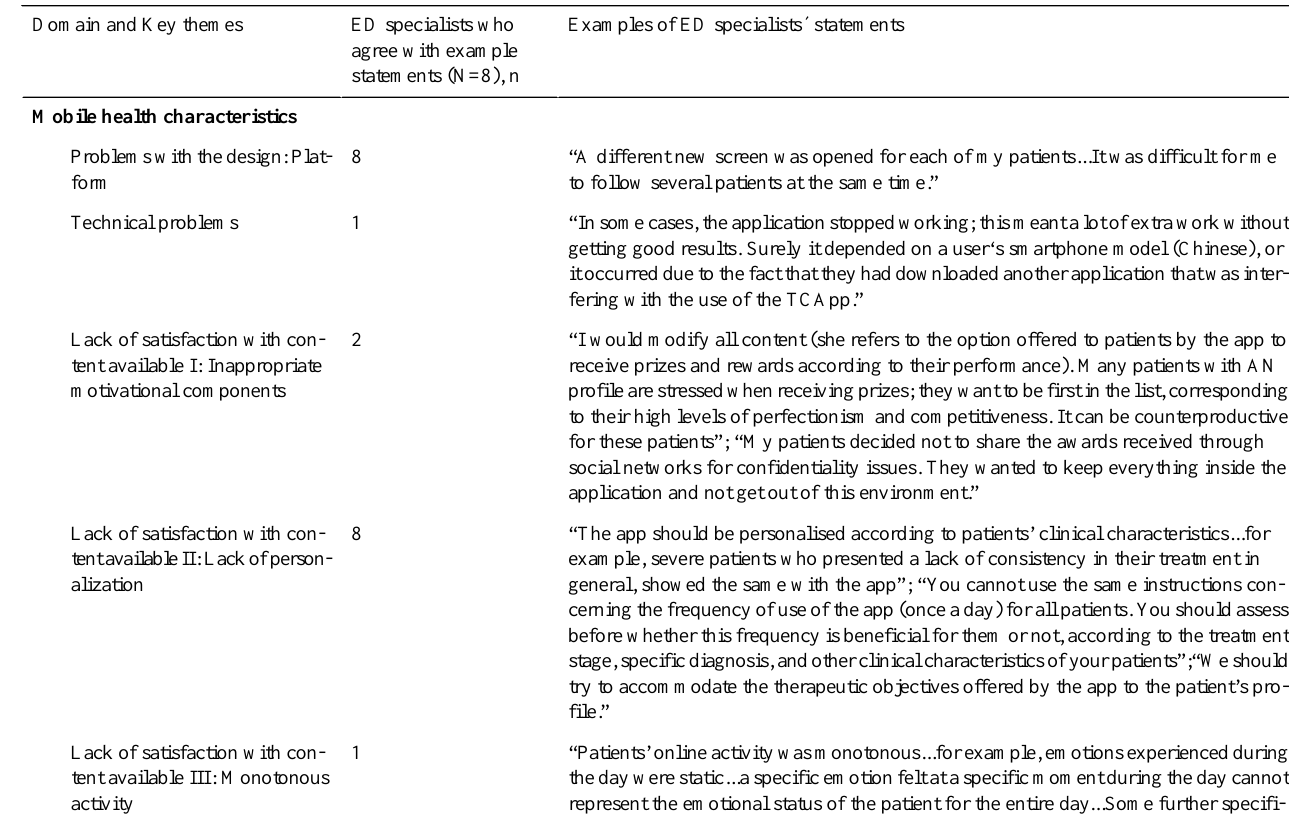
Table 8. Perceived disadvantages of the TCApp by eating disorder specialists.